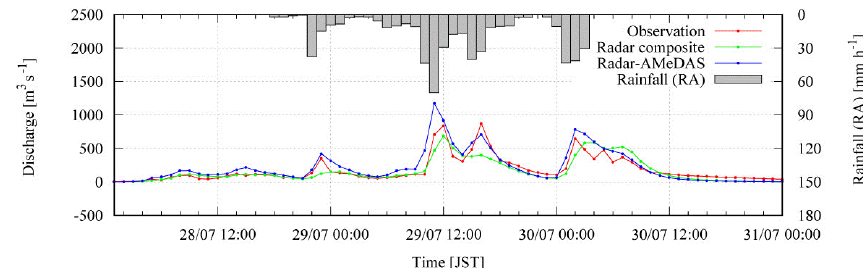
Figure 5. RA hyetograph, observed dam inflow, and simulated inflows with RA and